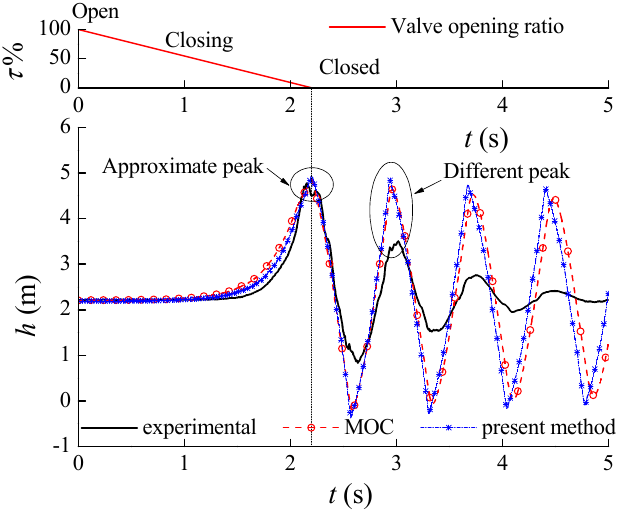
Figure 7. The transient-pressure process.